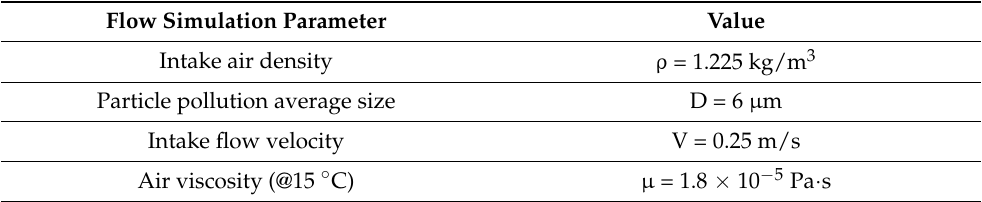
Table 2. Parameters used in CFD simulation of fluidic